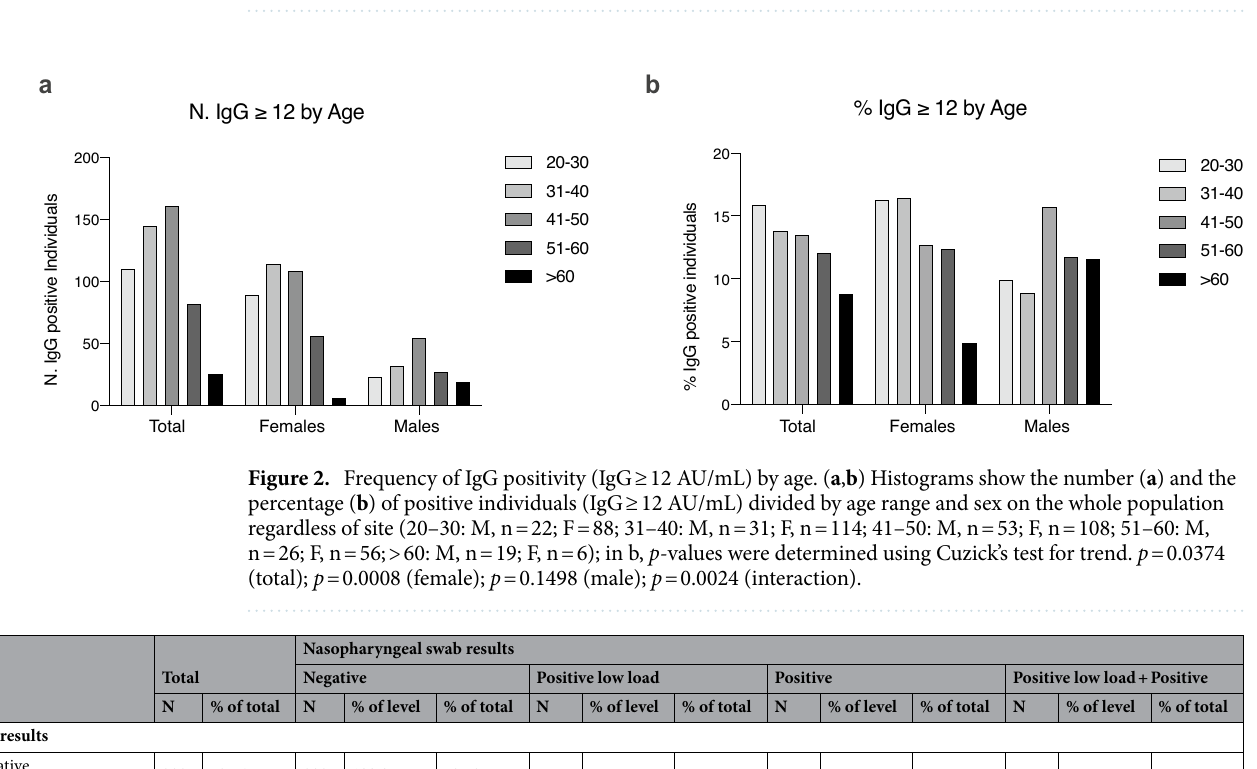
Table 2. Multilevel Logistic model for age, gender and their interaction, smoking habits, BMI.